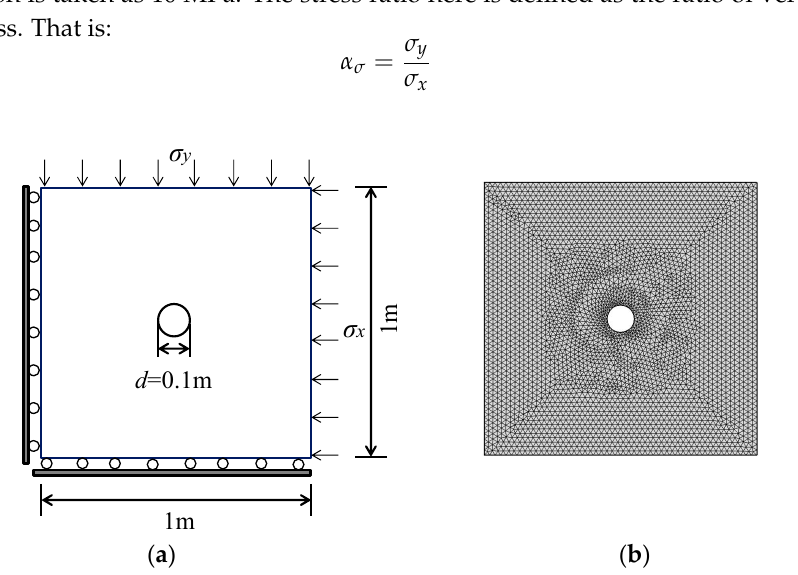
Figure 10. A computational model for shale. ( a ) Geometry model, ( b ) Grid model with 7008 triangular elements.